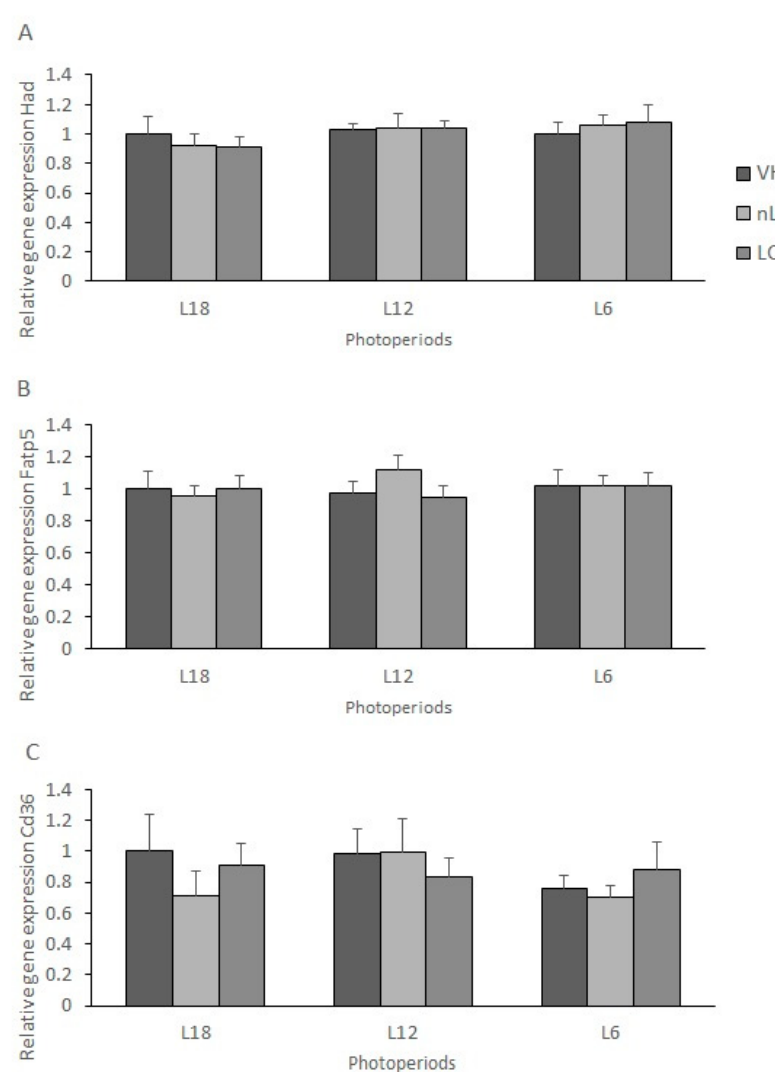
Figure 3. Gene expression of liver enzymes related to lipid metabolism. The mRNA levels of hydroxyacyl-CoA dehydrogenase (Had) ( A ), fatty acid transporter 5 (Fatp5) ( B ) and fatty acid translocase homolog of CD36 (Cd36) ( C ), of male Fischer 344 rats treated for 7 weeks with vehicle (VH), non-Local cherries (nLC) or Local (LC), and exposed to different photoperiods (short; L6, standard; L12 or long; L18). Values expressed as mean ± SEM ( n = 8). The values were normalized by the L18-VH group.